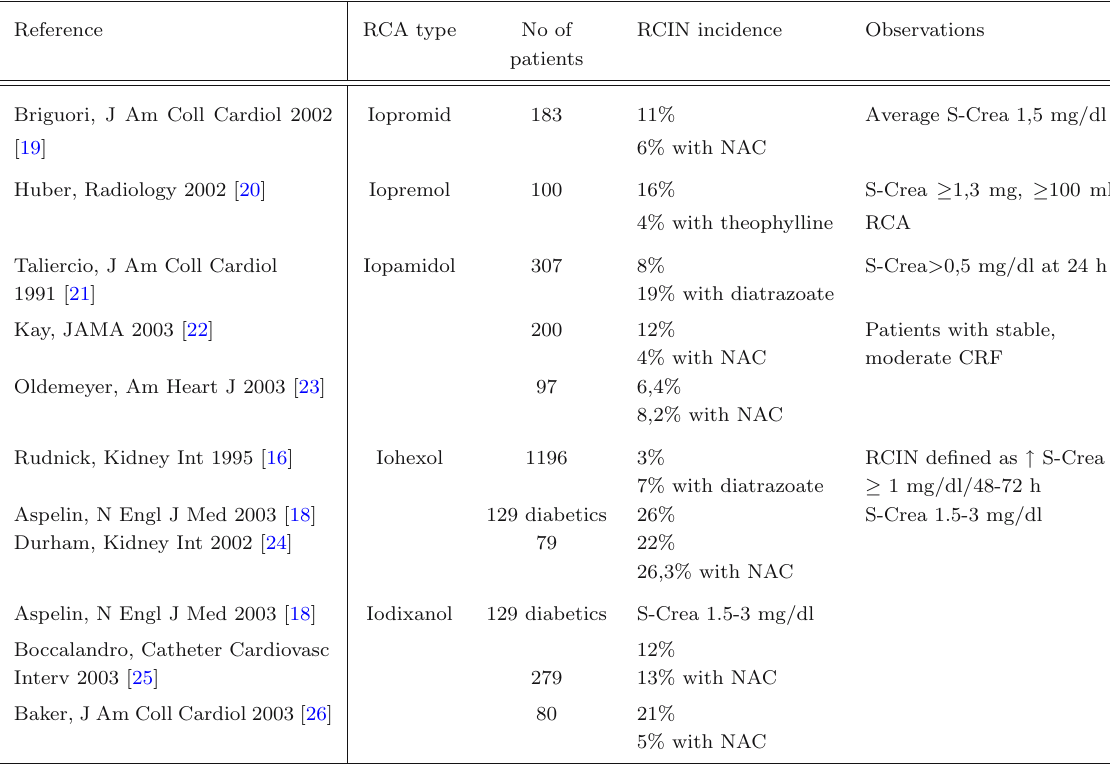
Table 5 Incidence of radiocontrast-induced nephropathyaccording to the use of